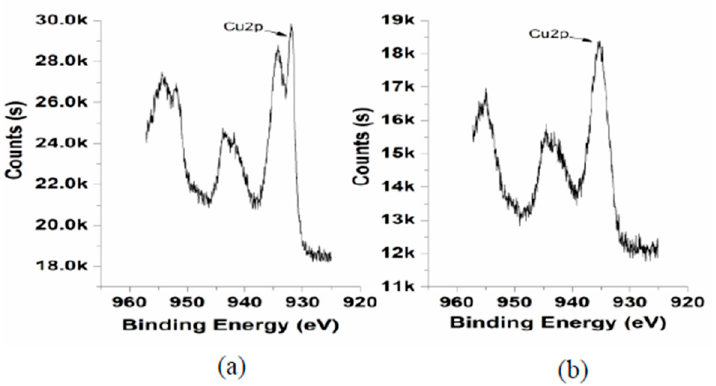
Figure 4. The XPS spectra of the ( a ) Ni and ( b ) O at the interface (80 kHz, 100 W).